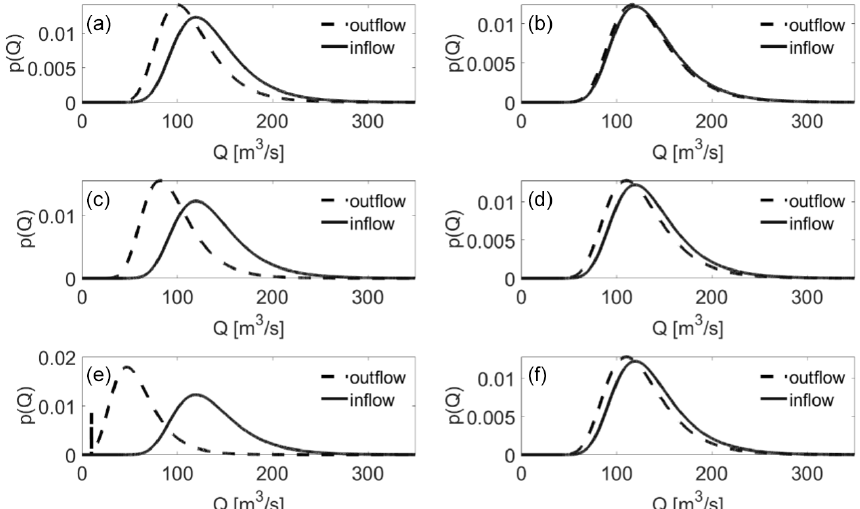
Figure 3. Derived probability density functions of the peak outflow obtained by modifying the height of the spillway crest ( h s ) and the equivalent event duration t p . Graphs on the left (a, c, e) are associated with a duration of half an hour and those on the right (b, d, f) to a duration of 1h, while elevation of the crest changes between 2 (a, b) , 4 (c, d) and 8m (e, f) . Other parameters are α = 30m 3 /s; β = 120m 3 /s;